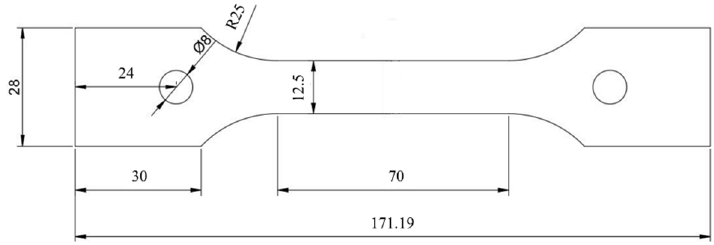
Figure 3. Dimensions of the uniaxial tensile-test sample (mm).